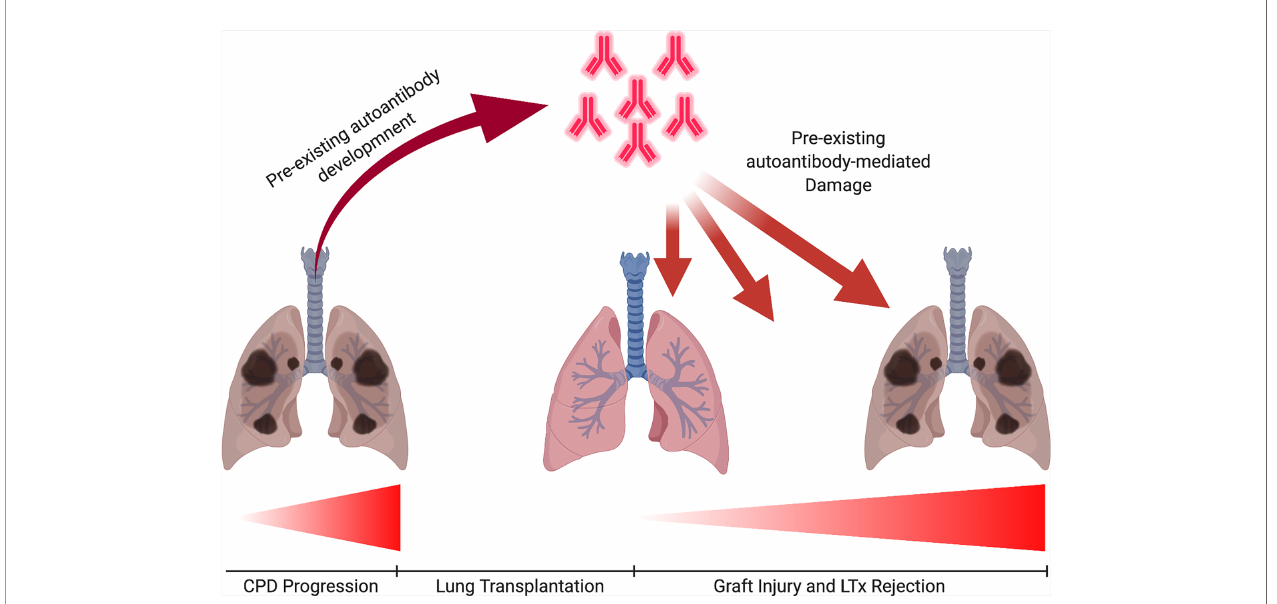
FIGURE 1 | Pre-existing Autoantibody-mediated Graft Injury. Autoantibodies developed as a consequence of chronic end-stage pulmonary diseases (CPD), such COPD and ILD may pre-dispose to worse graft outcomes. Autoantibodies characteristic of COPD and ILD have been shown to not only correlate with disease severity pre-transplant but hold the potential to target the lung and induce injury post-transplantation. Pre-existing autoantibodies that have been described can promote pro-in fl ammatory responses via a variety of effector pathways, including complement activation and Fc gamma receptor mediated in fl ammation, the impact of which on graft rejection has not been fully